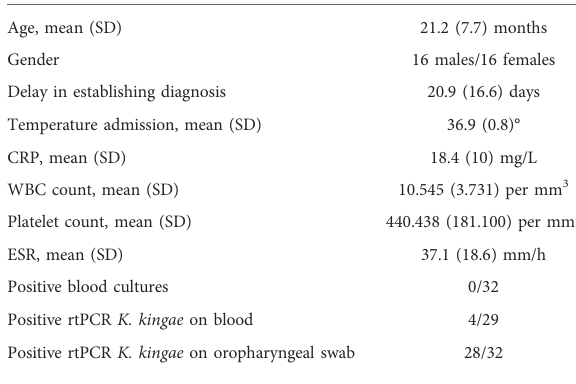
TABLE 1 Epidemiological, clinical, biological and bacteriological characteristics of spondylodiscitis in infants & children aged 6 months to 4